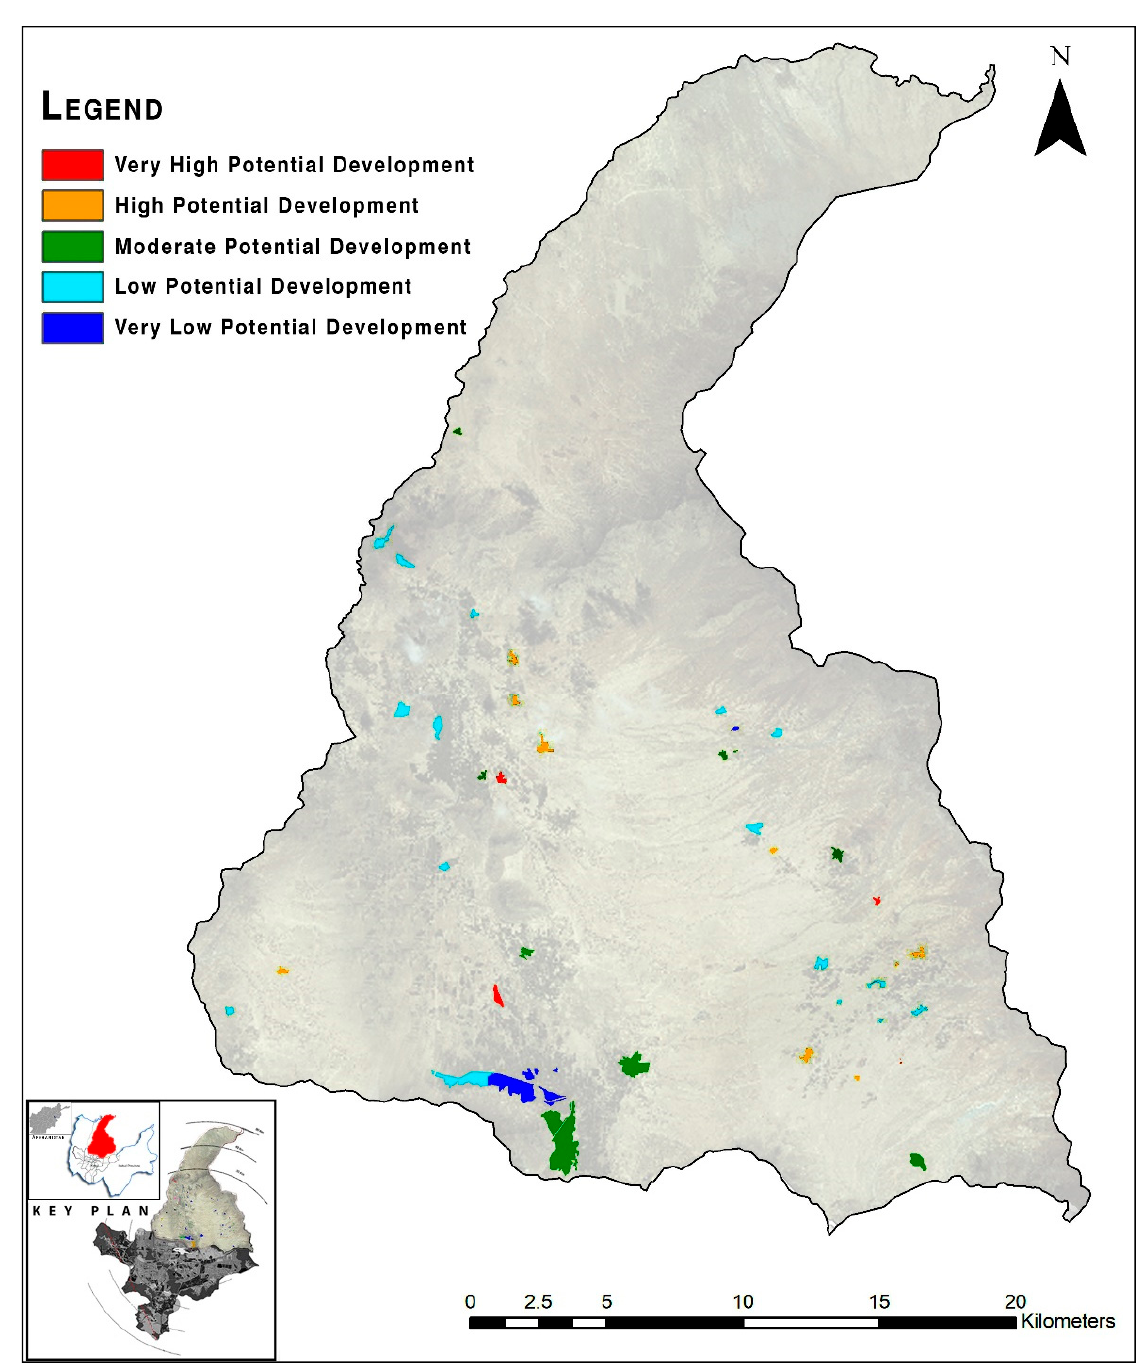
Figure 13. Final potential development model.